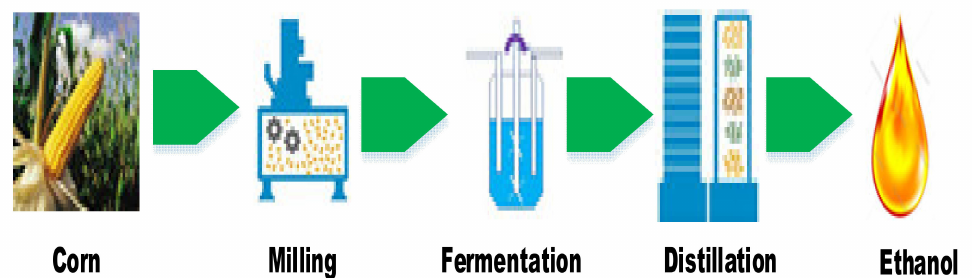
Figure 4. Schematic illustration of ethanol production from first-generation feedstock. Adapted from [58]. Developed by the